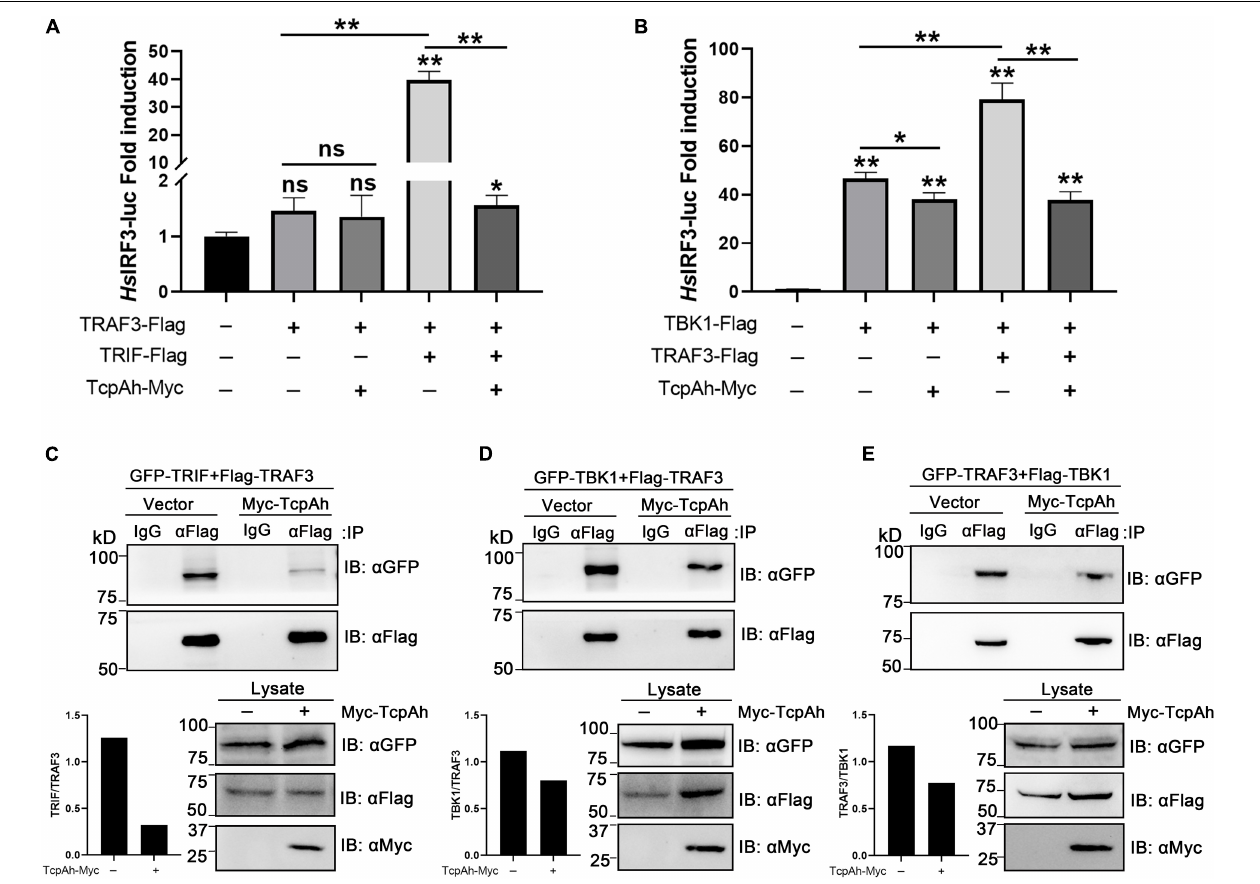
FIGURE 7 | Examination of the functional role of TcpAh in preventing TRIF–TRAF3 and TRAF3–TBK1 interactions. (A,B) Activation of human IRF3 promoter in HEK293T cells transfected with human IRF3 luciferase reporter ( Hs IRF3-Luc; 200 ng/mL), renilla luciferase reporter (15 ng/mL), and (A) zebrafish TRAF3 expression vector (50 ng/mL) alone or in combination with zebrafish TRIF expression vector (50 ng/mL) with or without TcpAh expression vector (500 ng/mL) or (B) zebrafish TBK1 expression vector (50 ng/mL) alone or in combination with a zebrafish TRAF3 expression vector (50 ng/mL) with or without TcpAh expression vector (500 ng/mL). Data are the average luciferase activity ± SD (* p < 0.05; ** p < 0.01; ns, not significant). (C–E) Co-IP analysis showing the inhibition of TRIF–TRAF3 and TRAF3–TBK1 interactions by TcpAh in HEK293T cells transfected with plasmids in indicated